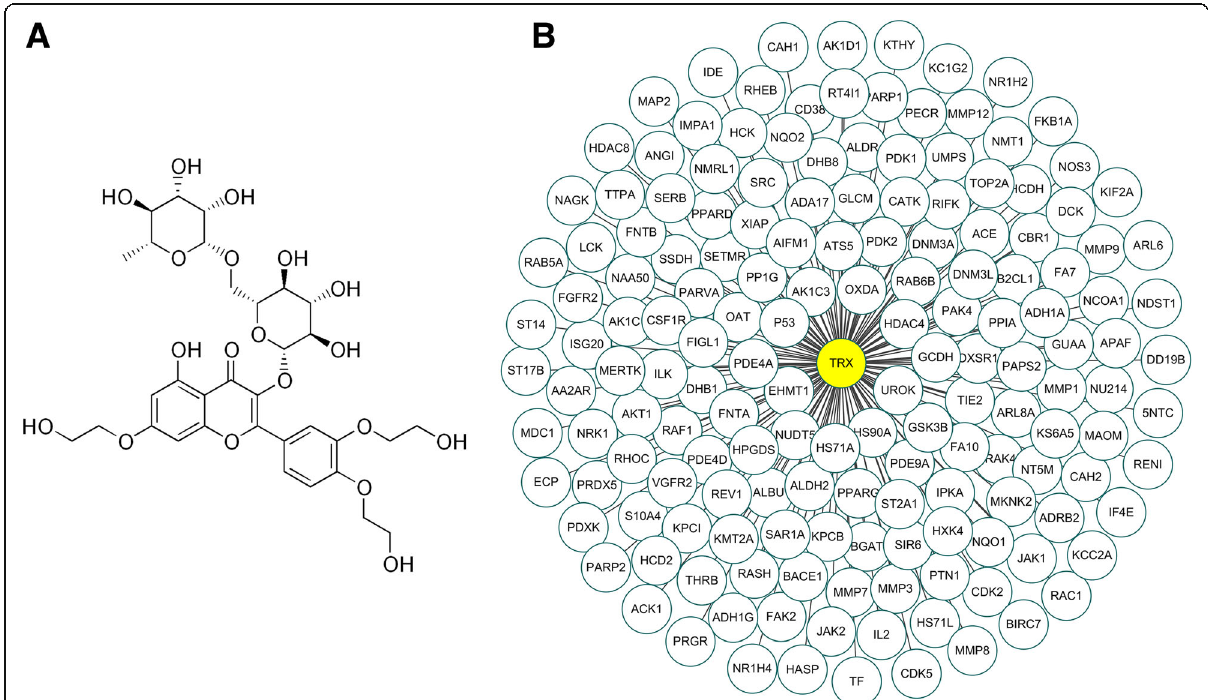
Fig. 1 The schematic structure and the predicted target proteins of troxerutin (TRX). ( a ) The chemical structure of TRX. ( b )162 potential targets of TRX that belong to species Homo sapiens had binding energies ranked in the top 100 from PharmMapper and the top 500 from